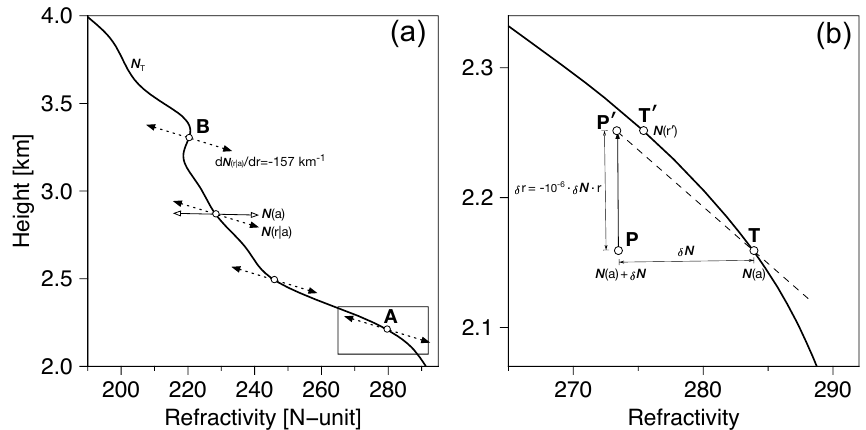
Figure 7. Illustration of solution’s trajectory in the posterior height determination (PHD). (a) The heavy solid curve represents the true refractivity sounding. The solid line with open-headed arrows around 2.8km, denoted N(a) , indicates the actual trajectory (i.e., connected line of positions) of potential solutions for a given refractional radius (or true height). PHD relocates the solutions, making the trajectory to be interpreted as the dotted, slanted line next to N (r | a) . (b) Magnified view of a relocation in the rectangular inset in panel (a) . In this example, the solution P is smaller than the true refractivity T and is thus relocated to P (cid:48) , which is from the true radius r to a higher location (cid:12) (cid:12) r (cid:48) since r = xn − 1 . This leads the apparent error (cid:12) P (cid:48) T (cid:48) (cid:12) to be smaller than the true error | PT | . The slope of P (cid:48) T is constant, − 157km regardless of the true height or the size of true error as shown by the dotted lines in panel (a) . See text for more